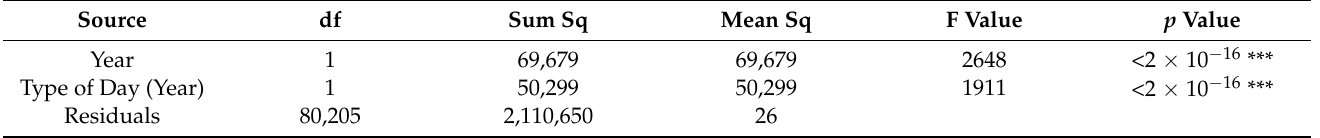
Table 1. Nested ANOVA of number of outings per